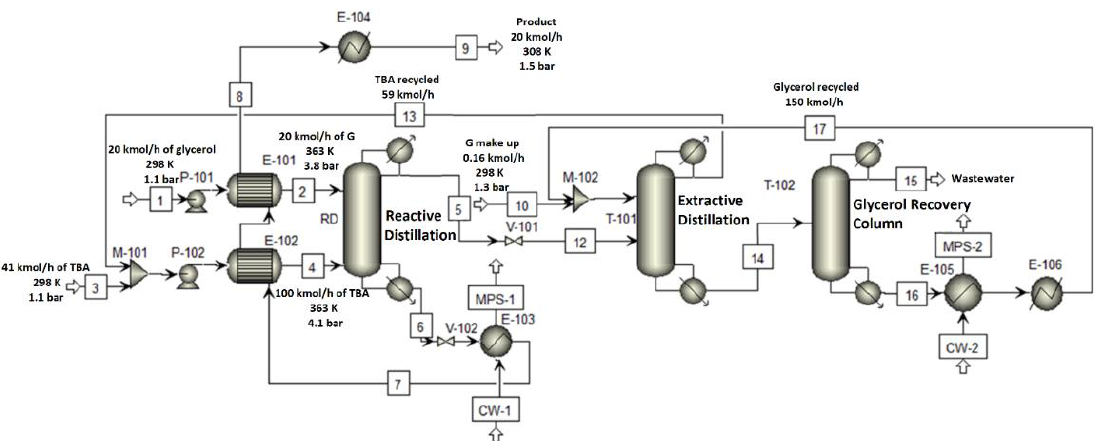
Figure 13. Heat-integrated process flow diagram (PFD) of glycerol etherification with TBA by reactive distillation. The two heat exchangers use the bottom stream of RD and T-102 because of their high temperatures of 560 and 572 K, respectively. The product stream (stream 7) is also used to heat the feeds in E-101 and E-102 at 363 K. The product (stream 8) is cooled in heat exchanger E-104. The product stream exiting the reactive distillation is used to heat the feed streams of glycerol and TBA in E-101 and E-102 instead of using a steam utility. The stream information of the integrated process is shown in Table 6. Table 6. Stream information of the integrated glycerol etherification process.